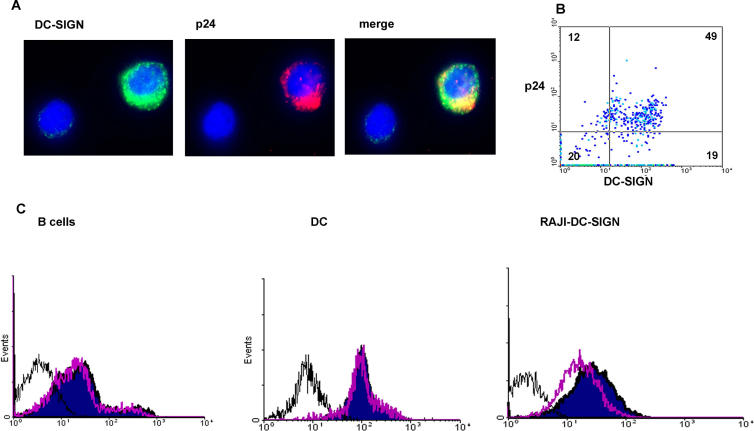
Expression of DC-SIGN and HIV-1 in B Cells(A) Immunofluorescent microscopy showing coexpression of DC-SIGN and HIV-1 in IL-4 and CD40L purified, activated B cells after 2 h of exposure to HIV-1 X4 (MN) at 37 °C. B cells not exposed to HIV-1 were used as controls; these included a subset that expressed DC-SIGN and were negative for HIV-1 (unpublished data). (600× magnification) Green indicates DC-SIGN, red indicates p24, and blue indicates DAPI.(B) Flow cytometry histograms showing coexpression of DC-SIGN and HIV-1 in IL-4 and CD40L purified, activated B cells after 2 h of exposure to HIV-1 X4 (MN) at 37 °C.(C) HIV-1 R5 (Ba-L) had no effect on expression of DC-SIGN by purified, activated B cells (left) or DC (middle), and minimally inhibited DC-SIGN expression in Raji–DC-SIGN cells (right) after 24 h incubation with the virus. Full histogram represents uninfected B cells; purple overlay histogram represents HIV-1–infected cells; and black overlay histogram represents isotype controls. Data are from single experiments representative of five independent experiments.